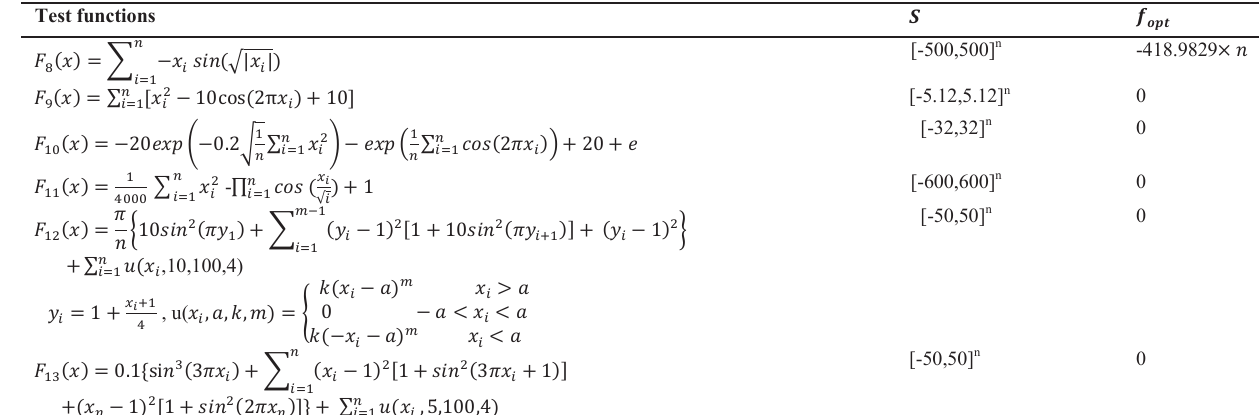
Table 2. Multimodal test functions.